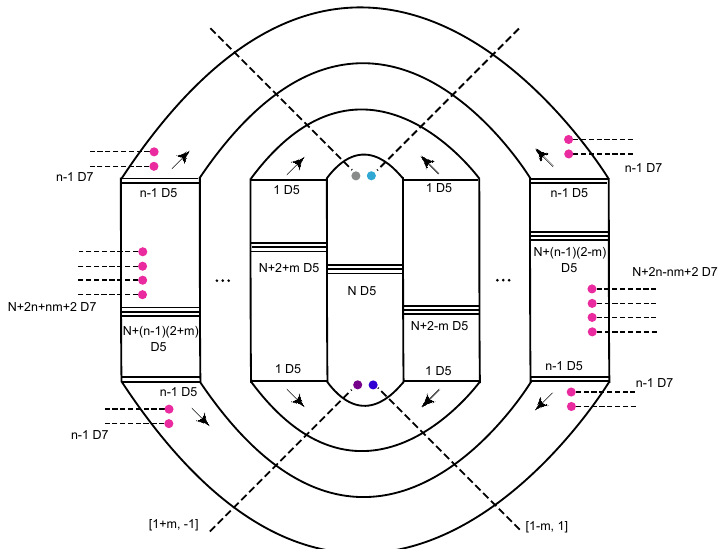
X . Relatively, it can be [1+ m; 1] [1 m; 1] (cid:0) (cid:0)